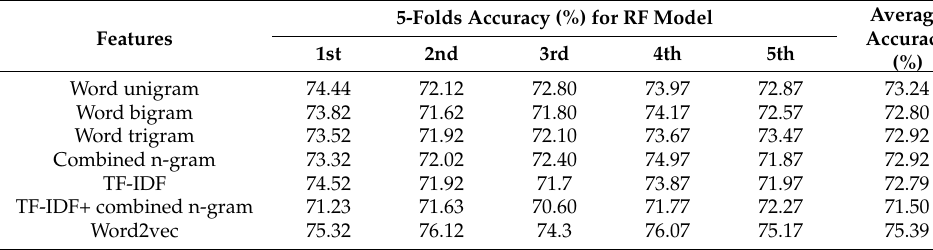
Table 9. RF models’ accuracy scores on each feature using the binary class dataset. Features